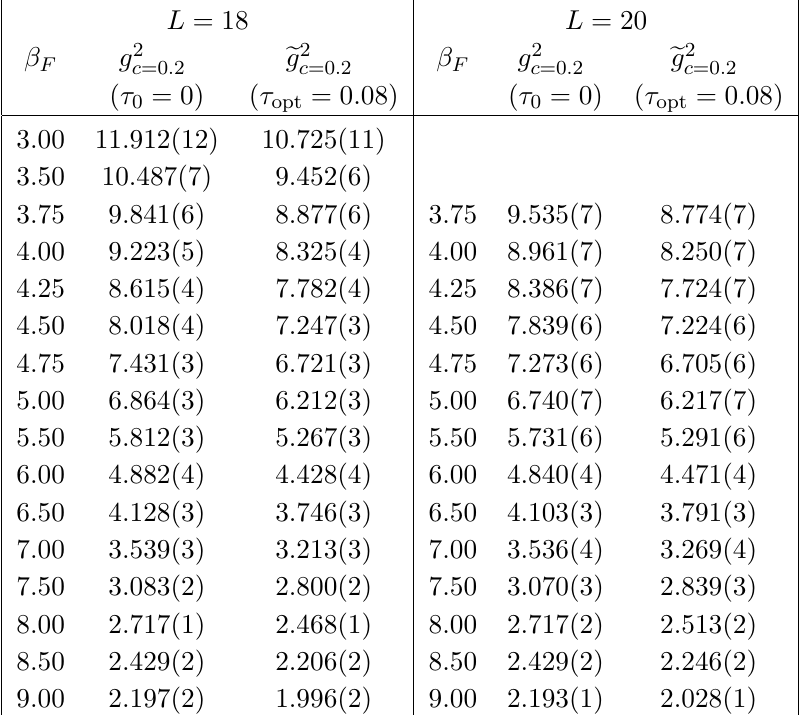
Table 12 . Renormalized gradient (cid:13)ow couplings in the c = 0 : 2 scheme for the 18 4 and 20 4 lattice ensembles used in this work, with columns as in table